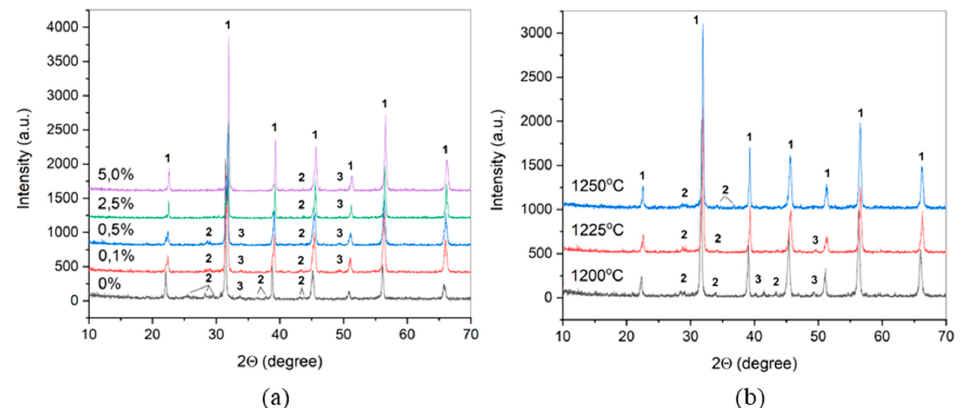
Figure 3. XRD patterns of BaTiO 3 ceramics prepared with Bi 2 O 3 addition: ( a ) sintered at 1225 °C with different amounts of Bi 2 O 3 ; ( b ) sintered at different temperature with 0.5 mol % Bi 2 O 3 . Numbers indicated the following phases from PDF-2 database: 1—BaTiO 3 (PDF-2 No. 00-074-1956); 2—BaTi 2 O 5 (PDF-2 No. 00-070-1188); 3—BaTi 4 O 9 (PDF-2 No. 00-077-1565).